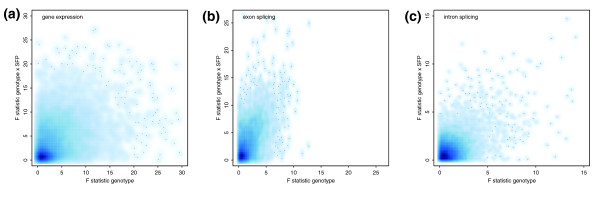
The effect of SFP probes on expression estimation. F statistics of genotype × SFP effects (y-axis) and that of genotype effects (x-axis) were obtained from the ANOVA model, Gene/exon/intron intensity = Genotype + SFP + Genotype × SFP + Error, for (a) gene expression, (b) exonic splicing, and (c) intronic splicing analysis.